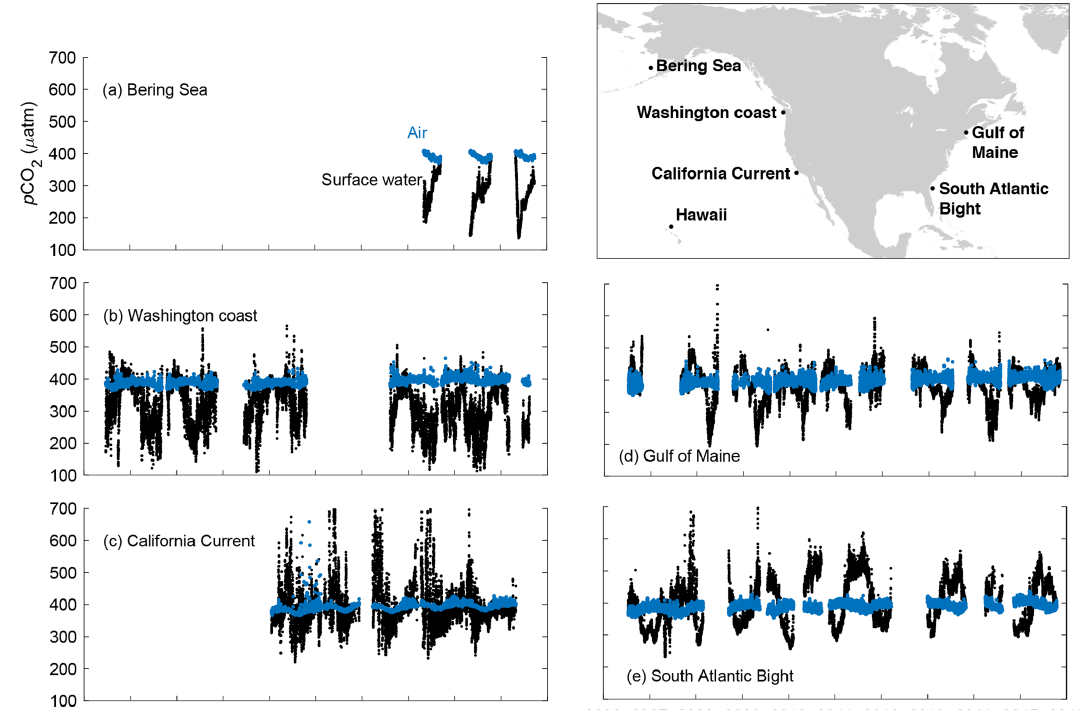
Figure 3. Observations of p CO 2 (in µatm) in the surface ocean (black) and overlying atmosphere (blue) at five coastal moorings. Map shows mooring locations. Also shown on the map is the location of the Hawaii Ocean Time Series (see Fig. 6). Data sources: Bering Sea (mooring M2; Cross et al., 2014a); Washington coast (Cape Elizabeth mooring; Mathis et al., 2013); California Current (mooring CCE2; Sutton et al., 2012); coastal western Gulf of Maine mooring (Sutton et al., 2013); South Atlantic Bight (Gray’s Reef mooring; Sutton et al.,